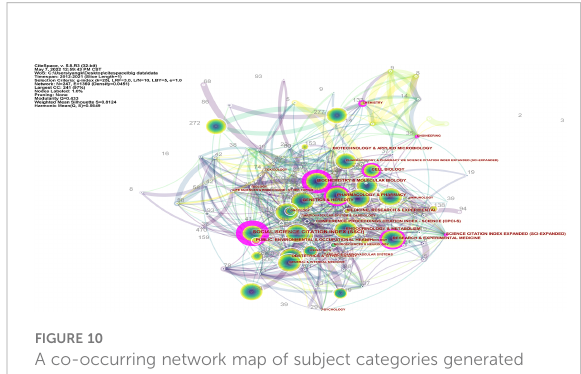
FIGURE 10 A co-occurring network map of subject categories generated by Citespace.